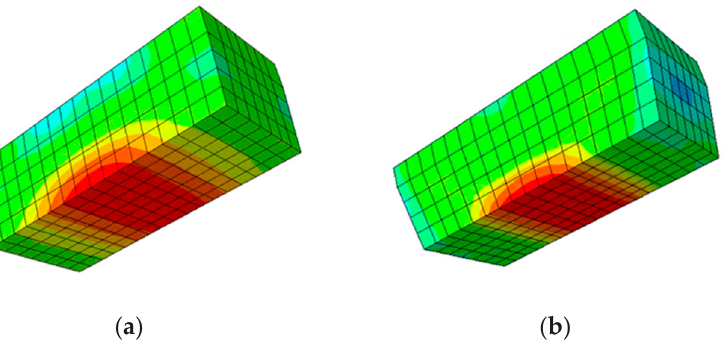
Figure 27. Stress cloud diagram of bearing block under vertical load. ( a ) bearing block of TLV. ( b ) bearing block of ILVT.